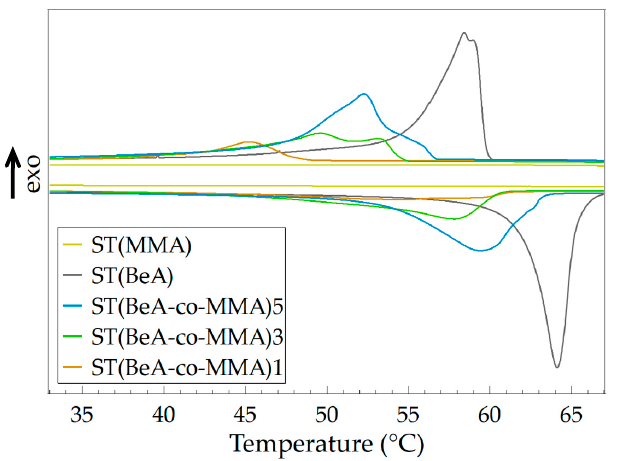
Figure 7. DSC curves of sheet samples for ST(BeA- co -MMA) copolymers with di ff erent monomer ratios and homopolymers ST(MMA) and ST(BeA) measured at a temperature changing rate of 5 ◦ C · min –1 . Table 5. Thermal properties of sheet samples measured at a temperature changing rate of 5 ◦ C · min –1 for the ST(BeA- co -MMA) copolymer with di ff erent monomer ratios and homopolymers ST(MMA) and ST(BeA).